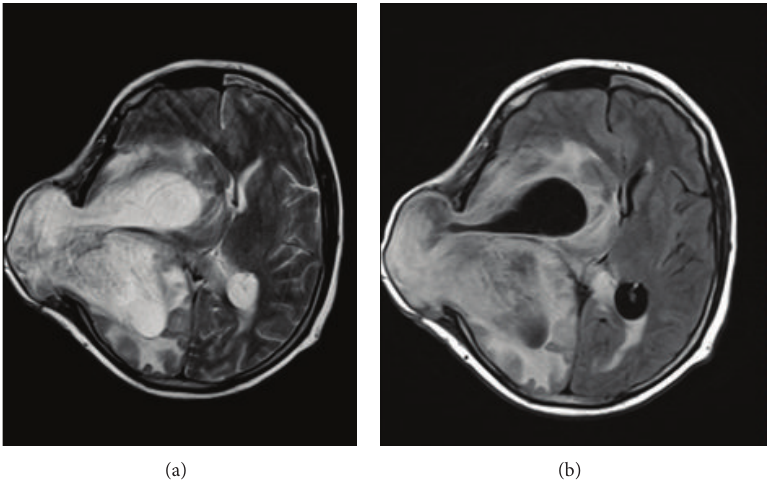
Figure 4: T2 weighted (a) and (b) FLAIR MR images of the lesion before the delivery on axial plane showing a recurrent lesion at the same location. In this figure we see herniated parenchymal tissue from craniectomy defect. There is midline shift about 18mm in diameter. Mesencephalon and pons retracted to left and there is also uncal